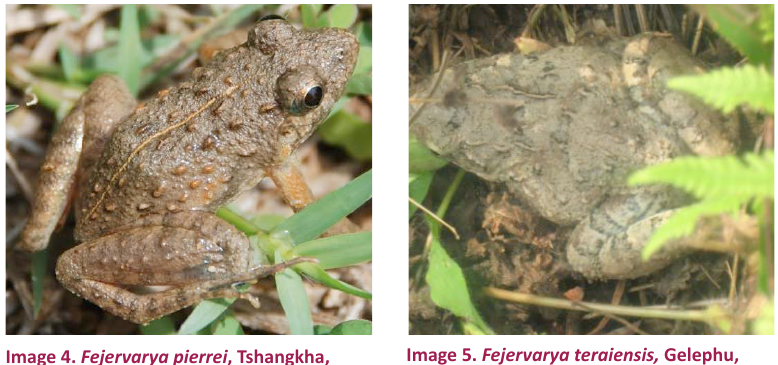
Image 4. Fejervarya pierrei , Tshangkha, Dagana. © Jigme Tshelthrim Wangyal